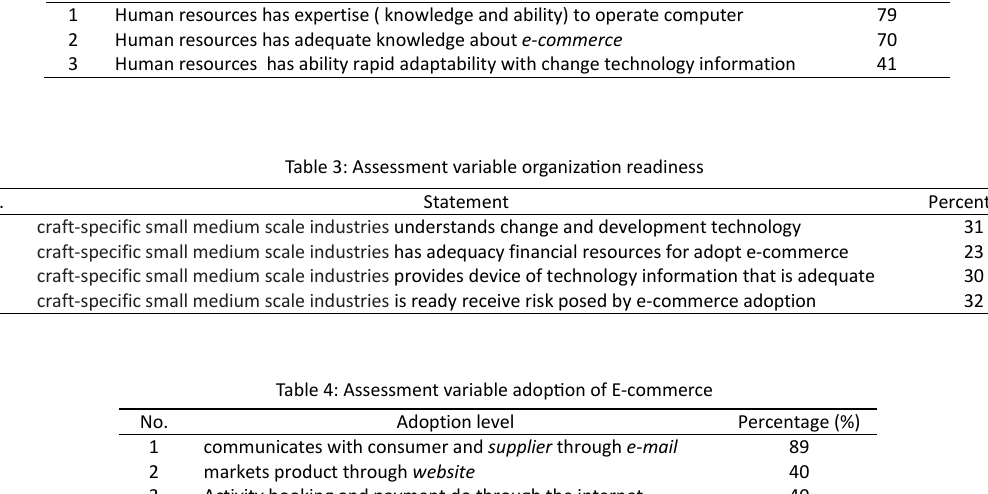
Table 2. Human resources technology competencies